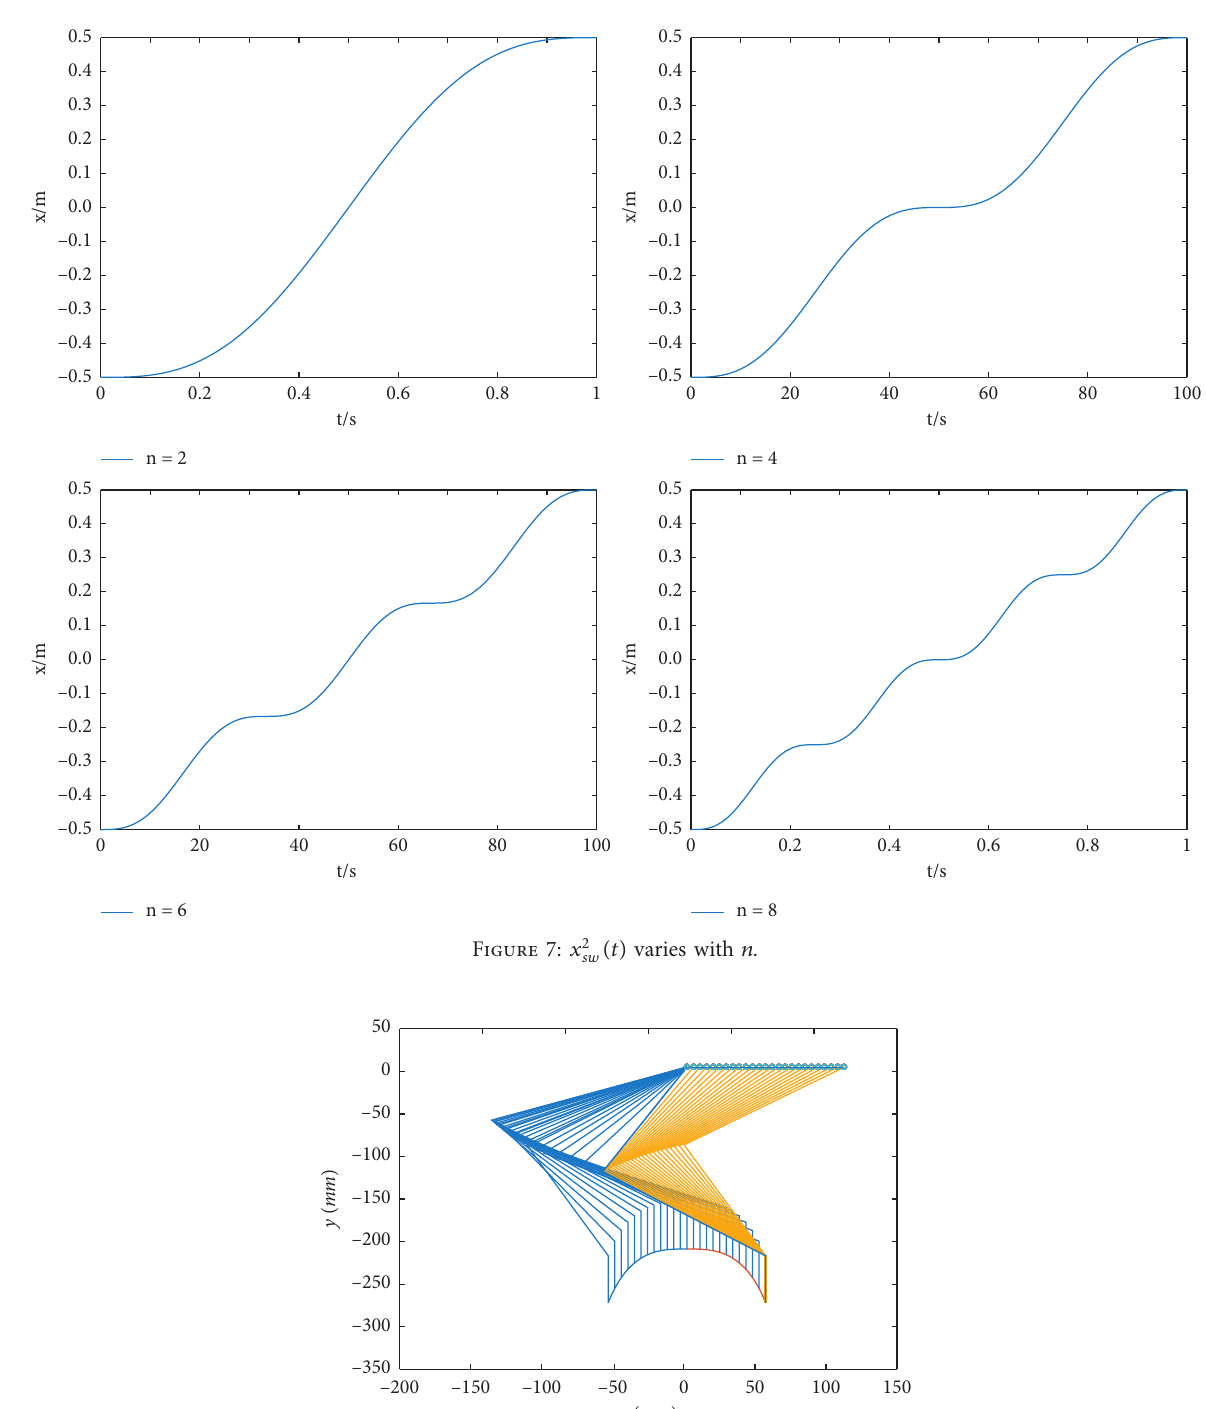
Figure 8: Foot trajectory of one front